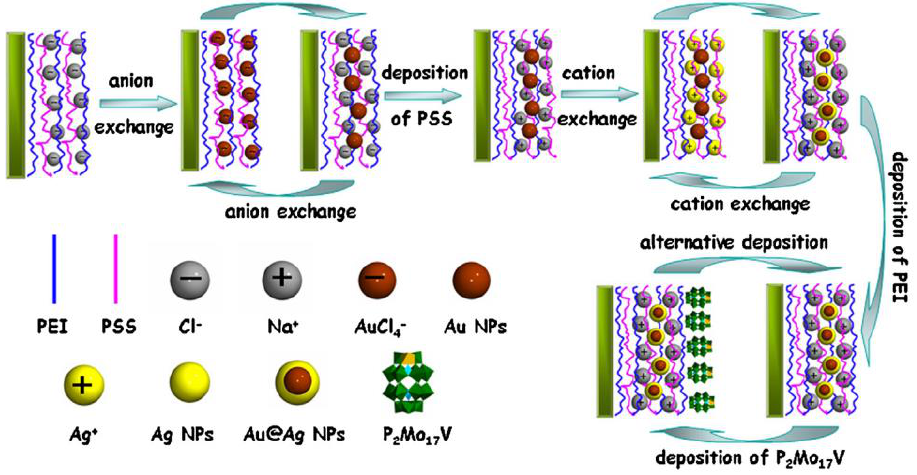
Figure 7. The schematic illustration of a composite film containing Au@2Ag core-shell nanoparticles. Reprinted from [75] with permission from the Elsevier.